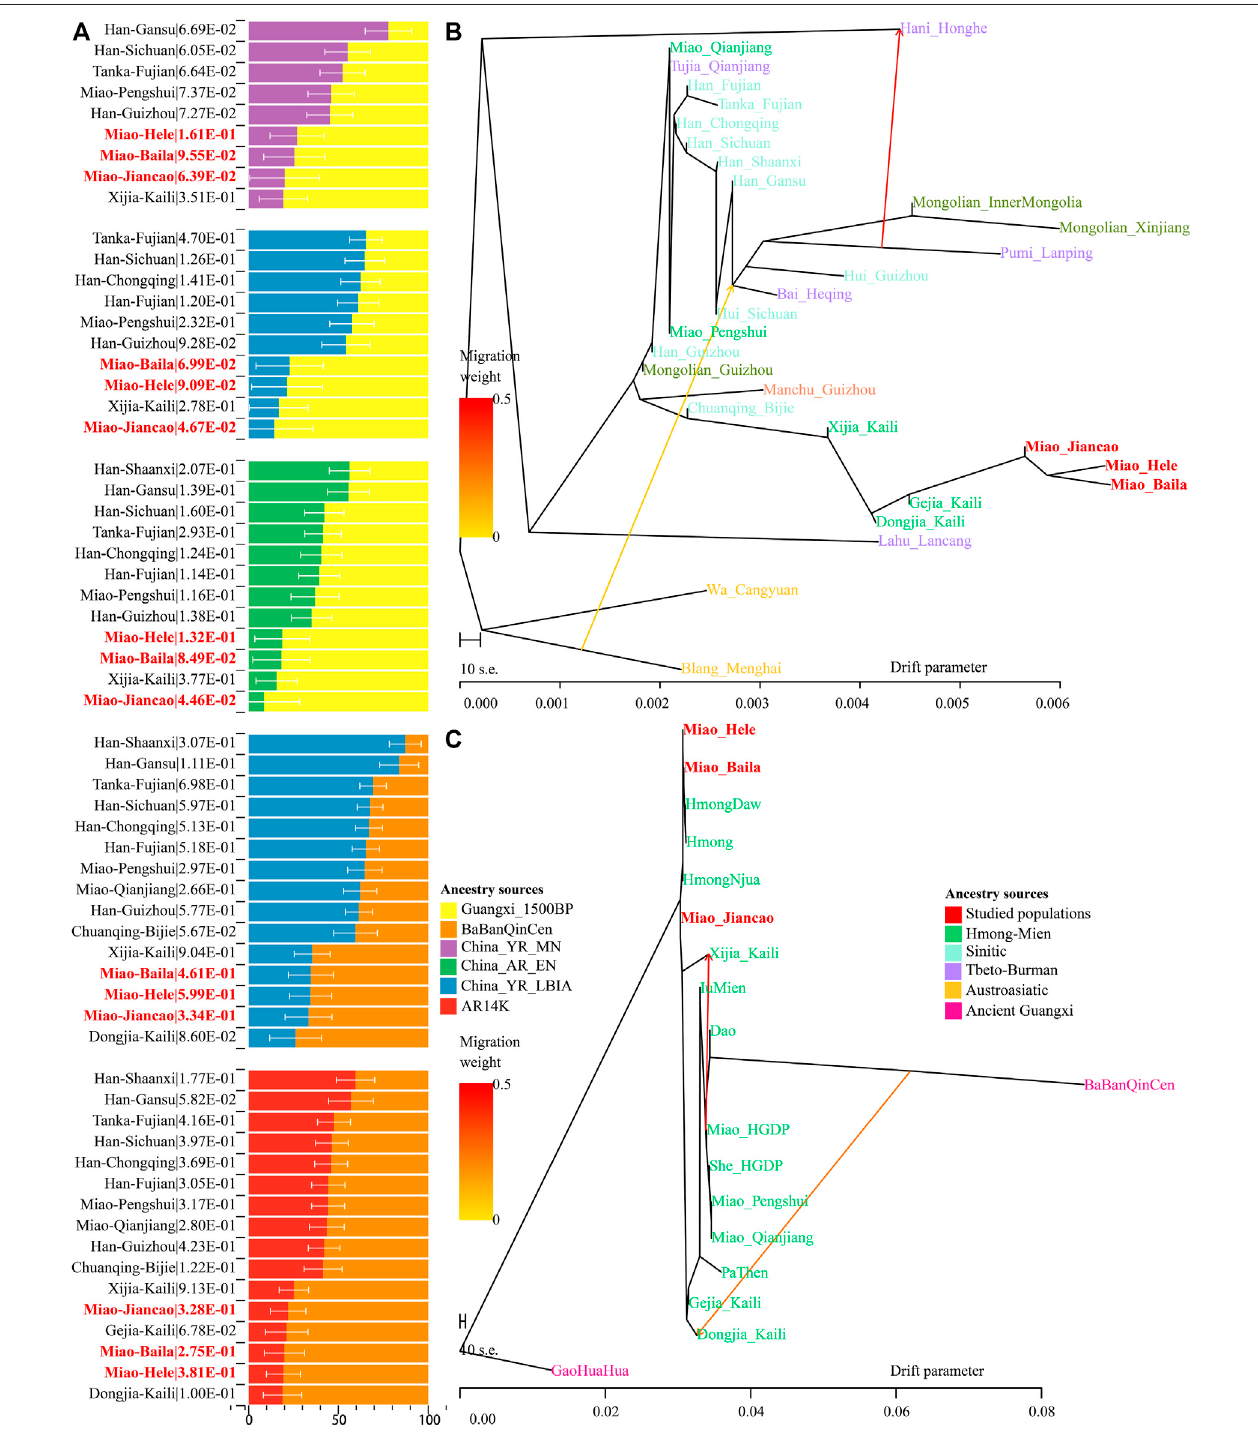
FIGURE5| ResultsofqpAdmmodelsandTreeMix-basedphylogenies. (A) Two-wayadmixturemodelsshowedancestrycomparisonindifferentancestralsource pairs. (B,C) TreeMix-based phylogenetic tree with two migration events showed the genetic relationship between East Asians.